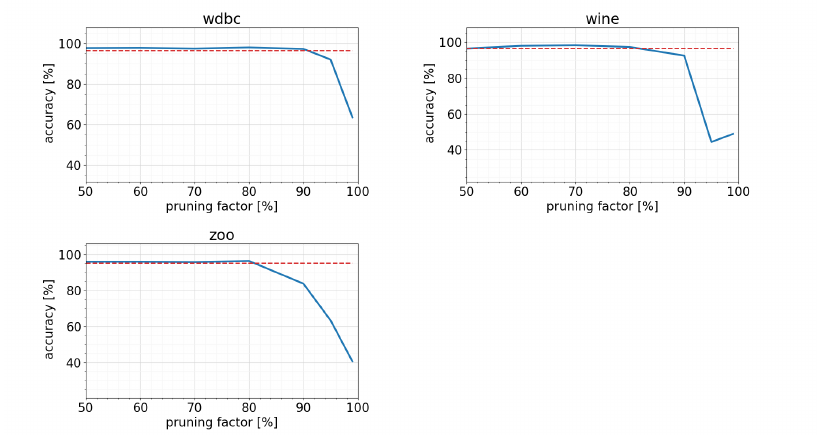
Figure 14. Results of pruning MLP ANN structure on wdbc, wine and zoo